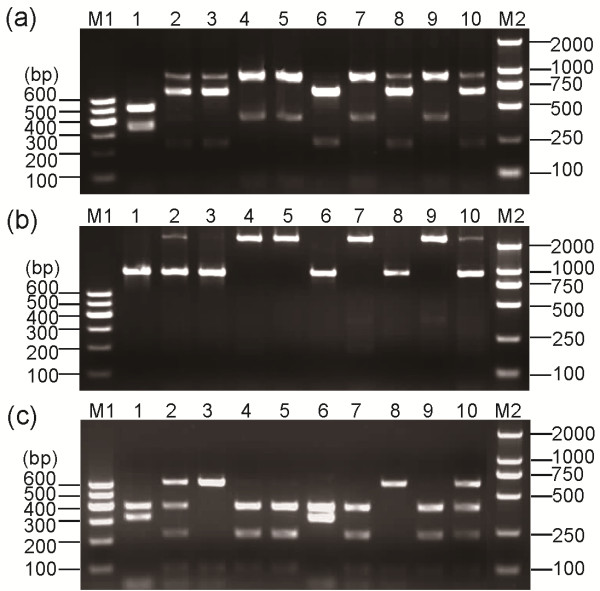
(a)DraI and (b)XbaI PCR-RFLP profiles of esterase B and (c)ApaLI PCR-RFLP profiles of esterase A from the R-SG population. M1, Marker I; M2, Marker D2000; 1–10, as described in Figure 5